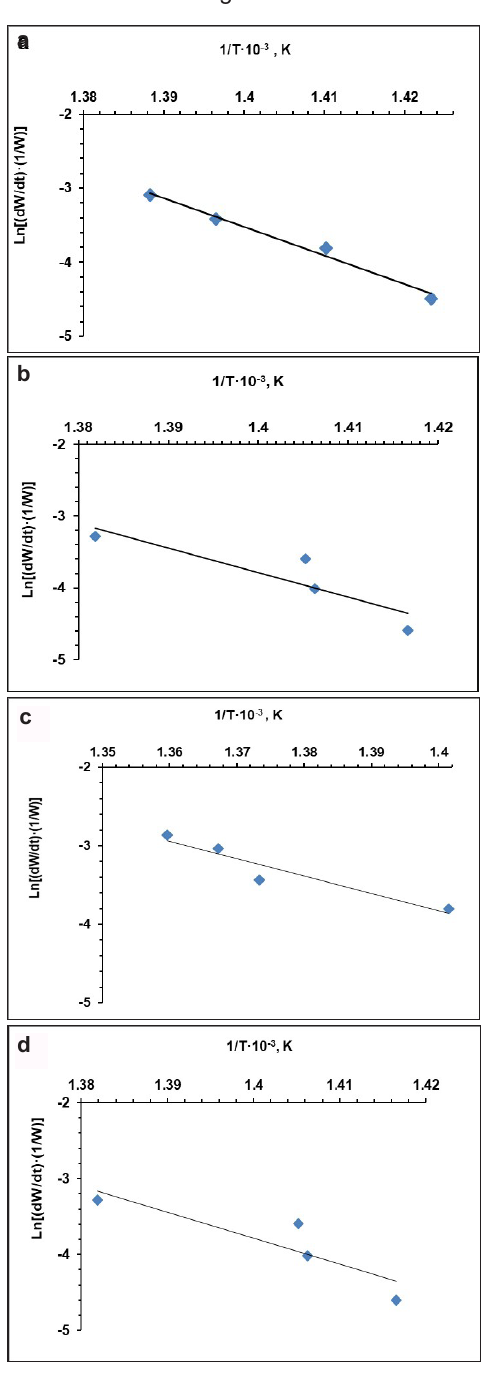
Fig. 3. Plot of first order equation for TG curves of coals a-Aduun chuluun, b-Baganuur, c-Ulaan ovoo, d-Shivee